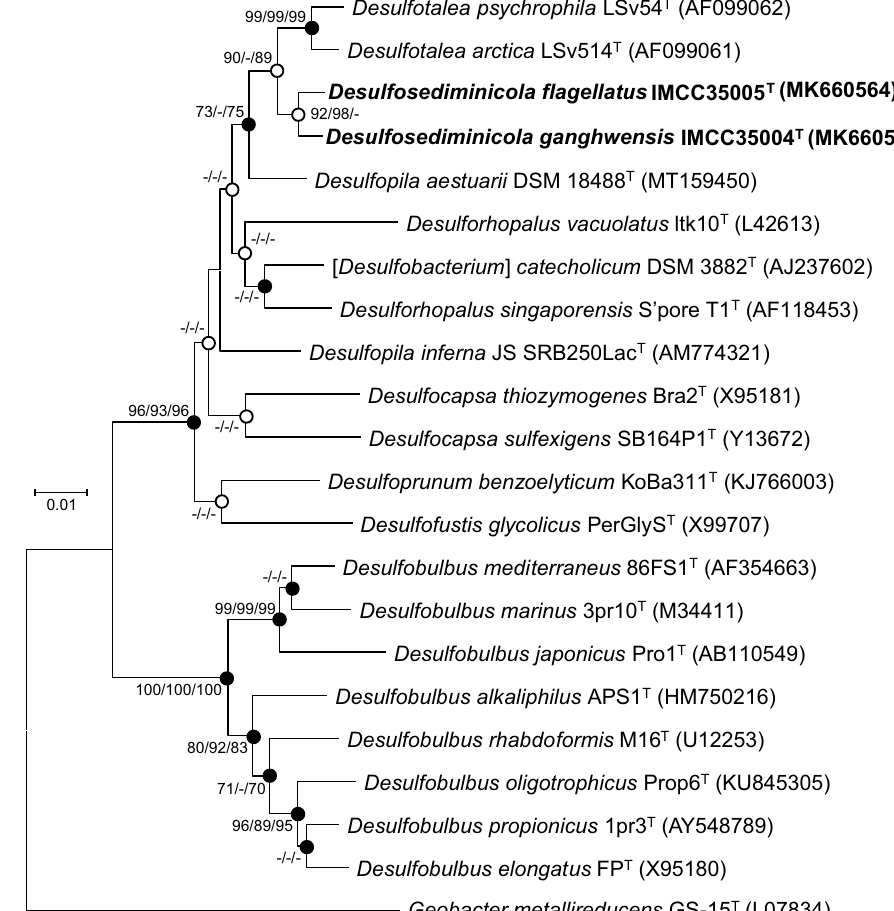
Figure 1. Positions of strains IMCC35004 T and IMCC35005 T on the neighbor-joining phylogenetic tree based on the 16S rRNA gene sequences. Filled circles indicate that the corresponding nodes were identified from all the treeing methods. Open circles indicate the nodes identified from the two treeing methods. The bootstrap values (expressed as percentages of 1000 replications) are shown at nodes for neighbor-joining, minimum- evolution, and maximum-likelihood methods; only the values ≥ 70% are shown. The GenBank/EMBL/DDBJ accession numbers are shown in parentheses. Geobacter metallireducens GS-15 T (L07834) was used as an outgroup. The bar represents 0.01 nucleotide changes per